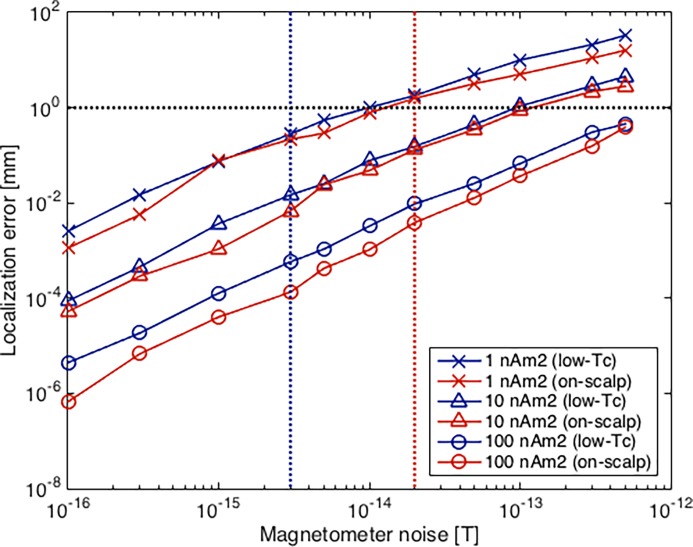
Localization error vs. SNR.Mean localization error with low-Tc (solid blue) and on-scalp (solid red) systems for different magnetometer noise levels and localization coil magnetic moments (both axes plotted logarithmic). Typical noise levels are marked by vertical blue (low-Tc) and red (on-scalp) dotted lines. The horizontal black dotted line indicates 1 mm localization error.